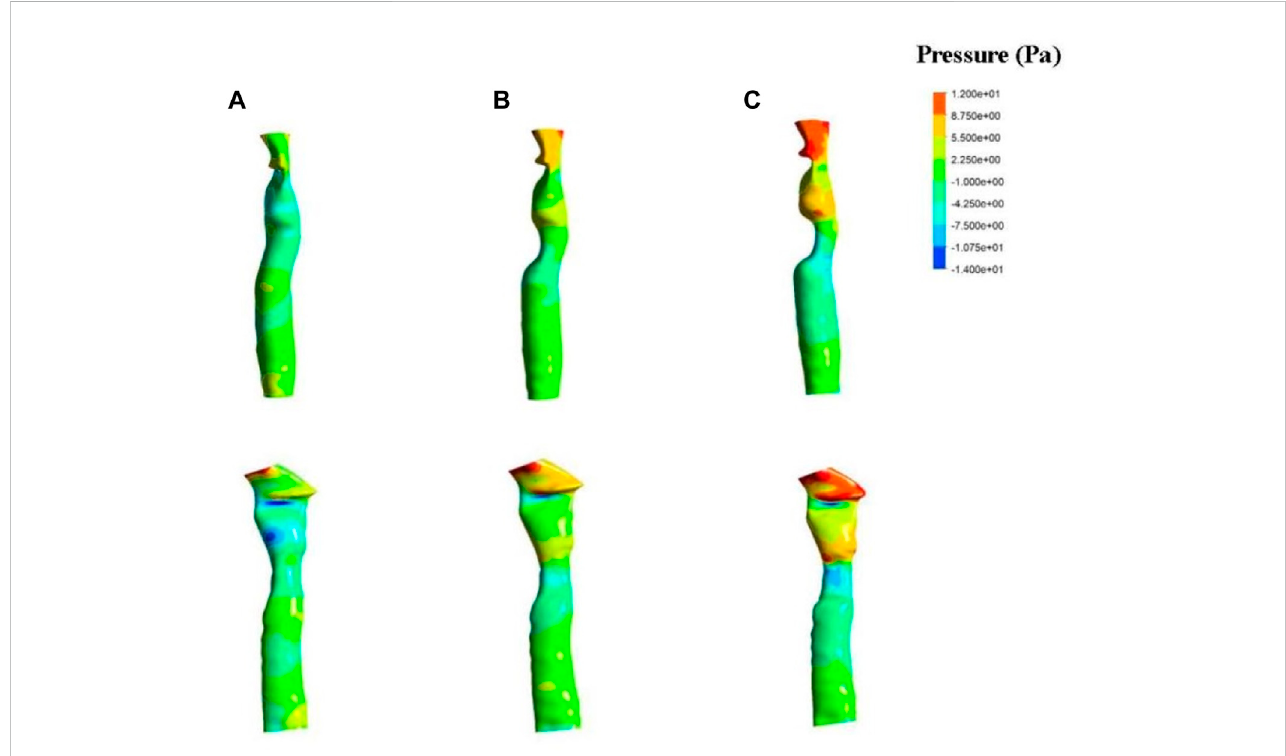
FIGURE 4 Results of fl uid pressure in patient one. The anterior view (top) and lateral view (bottom) of a normal trachea (A) , a trachea with 33% stenosis (B) and a trachea with 50% stenosis (C)